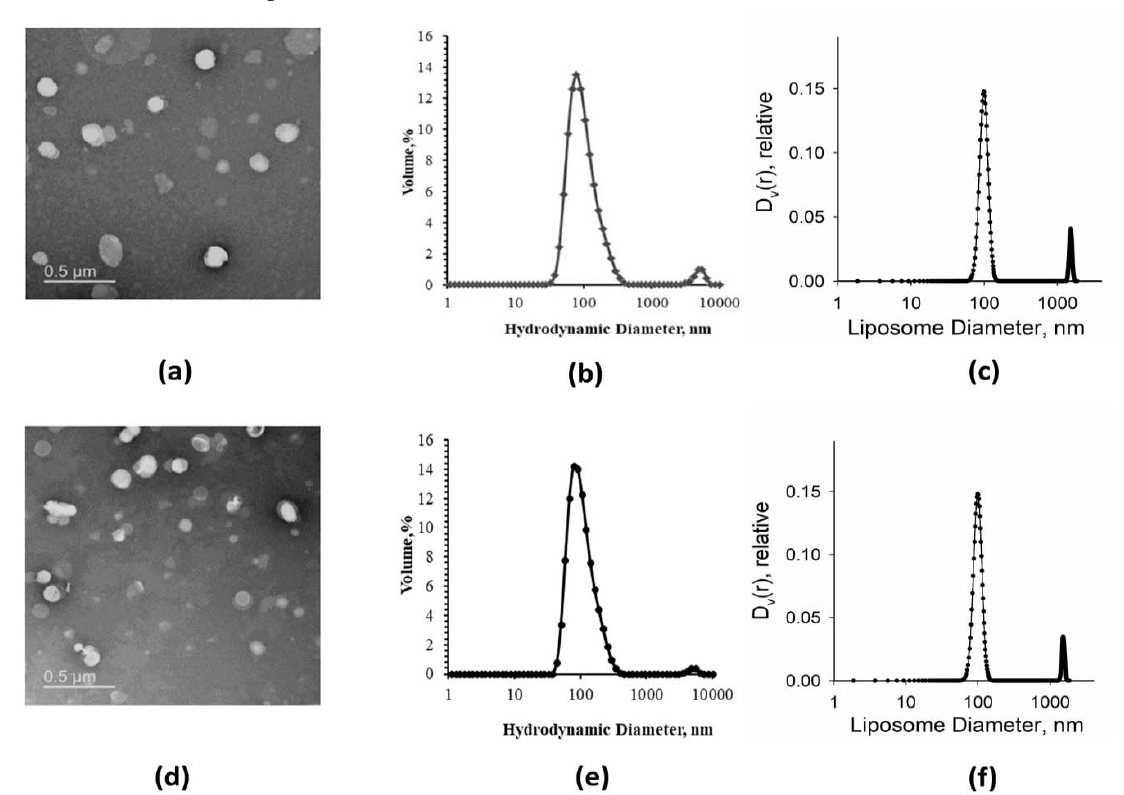
Figure 2. Size estimation of synthetic liposomes. Represented are EM images ( a , d ), DLS analysis data ( b , e ), and SAXS analysis data ( c,f ) obtained for synthetic liposomes composed of 10 mol.% of DOPS + 90 mol.% of DOPC mixture ( a – c ) or 30 mol.% of DOPS + 70 mol.% of DOPC mixture ( d – f ).